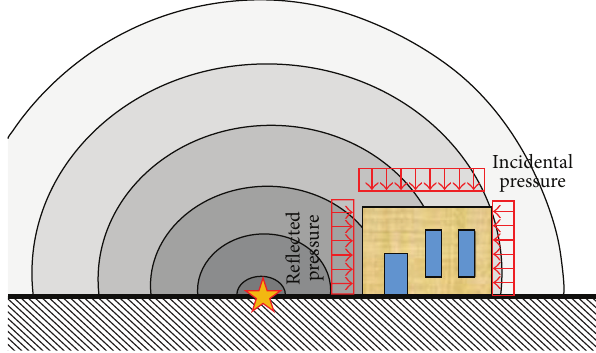
Figure 2: Schematic representation of the evolution of a surface blast wave in space; reflected and main pressure blast wave on an adjacent